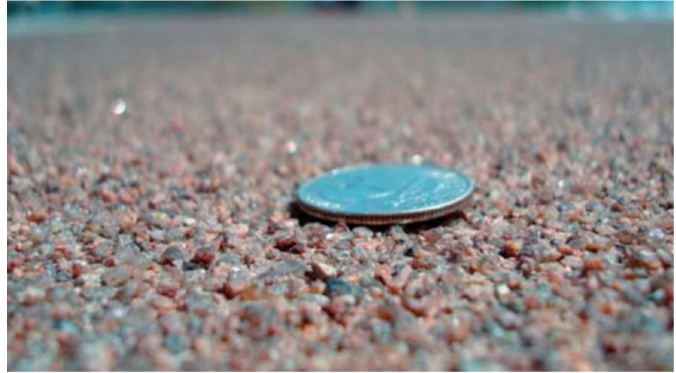
Figure 11. High-friction surface dressing.